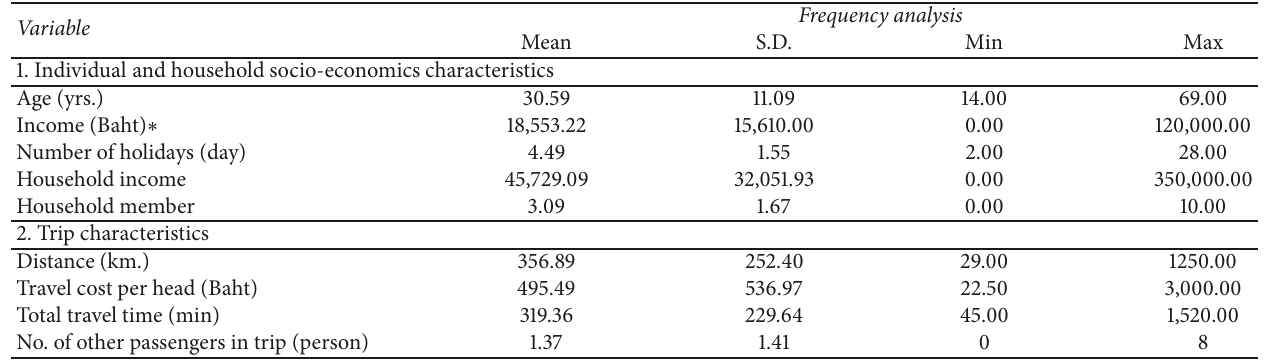
Table 2: General characteristics of